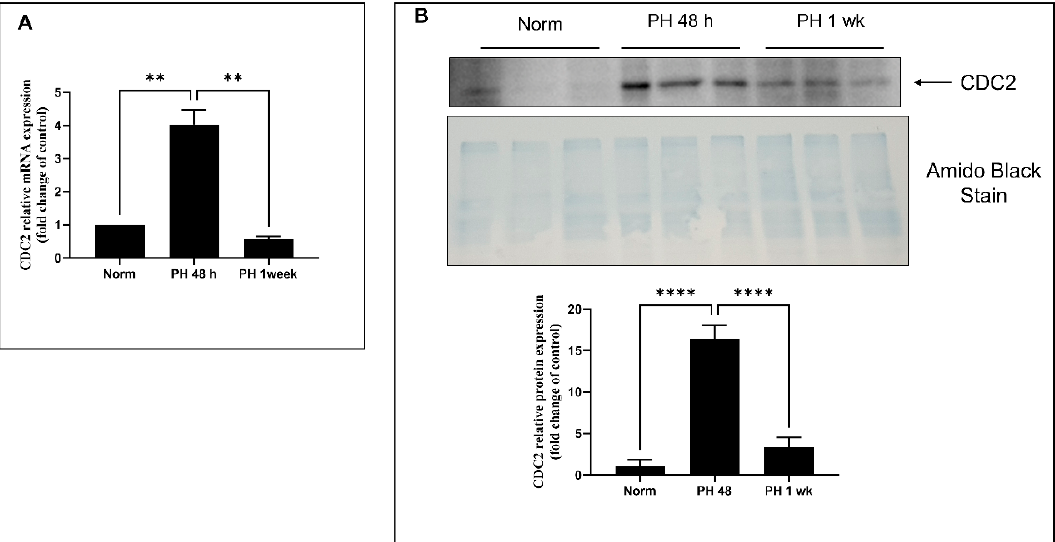
Figure 6. Expression of CDC2 in pulmonary arteries of rat PH model. SD Rats were treated with sugen/hypoxia for 48 h or 1 week or vehicle in normal air (norm) over the same period. Main trunk pulmonary arteries from these rats were tested for expression of CDC2 at the RNA ( A ) and protein ( B ) levels. All treatments were done in triplicate, and the experiments were done in duplicate. Representative experiments are shown. n = 3 for each group. Bar graphs indicate group means for these experiments and the error bars represent the standard deviation. **- p < 0.01 and ****- p < 0.0001.